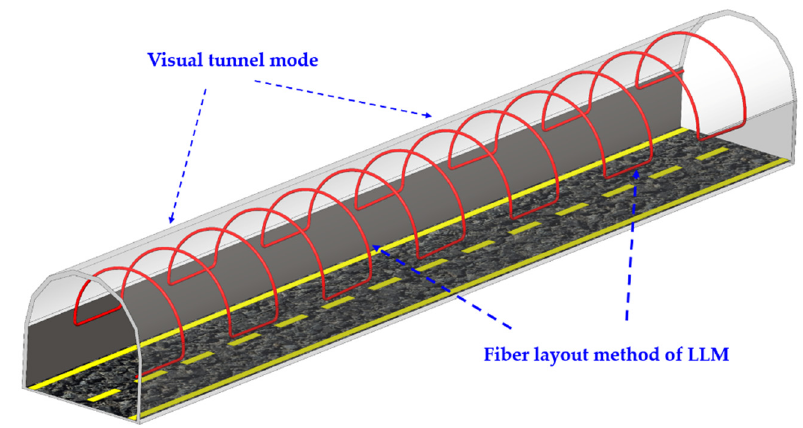
Figure 2. Visual tunnel model and the longitudinal lining model for fiber layout in tunnel.